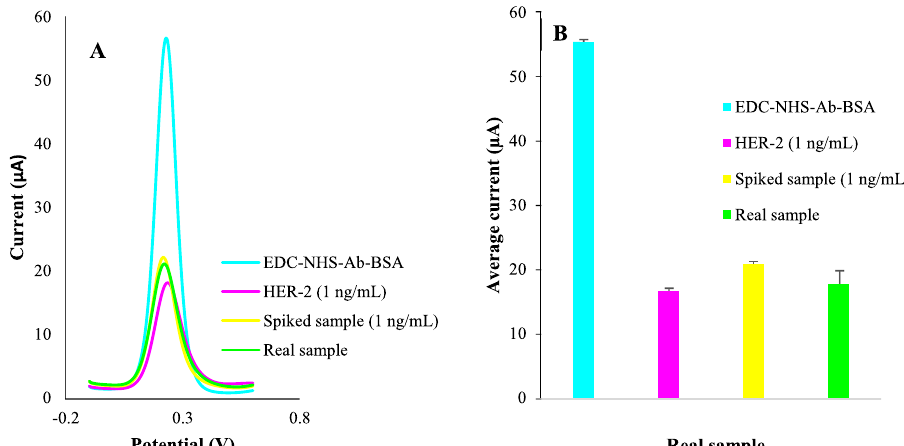
Figure 6. Analysis of a real sample of HER-2 positive patient and comparison of the correlated signals with a standard solution of HER-2 protein (1 ng/mL) and healthy real sample spiked with HER-2 protein (1 ng/mL). The electrochemical measurements were obtained in a PBS buffer (pH = 7.4) of 5 mM K 4 [Fe(CN) 6 ] and 0.1 M KCl. All the DPV measurements were obtained in tha potential range of -0.1–0.6 V with pulse amplitude of 5 mV with interval time of 0.5